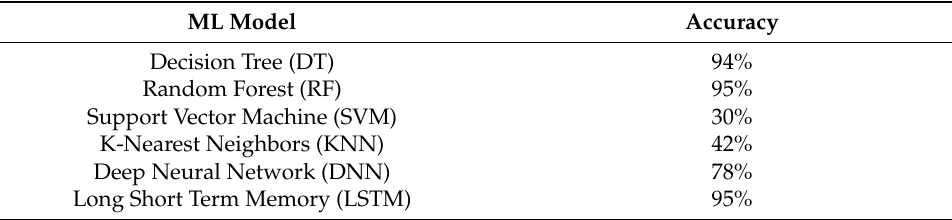
Table 2. Accuracies of ML classifiers for charging station classification.